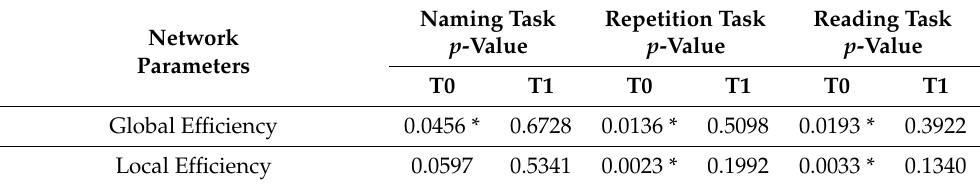
Figure 6. AAT test score at T0 and T1. Table 1. Results of the Wilcoxon rank-sum